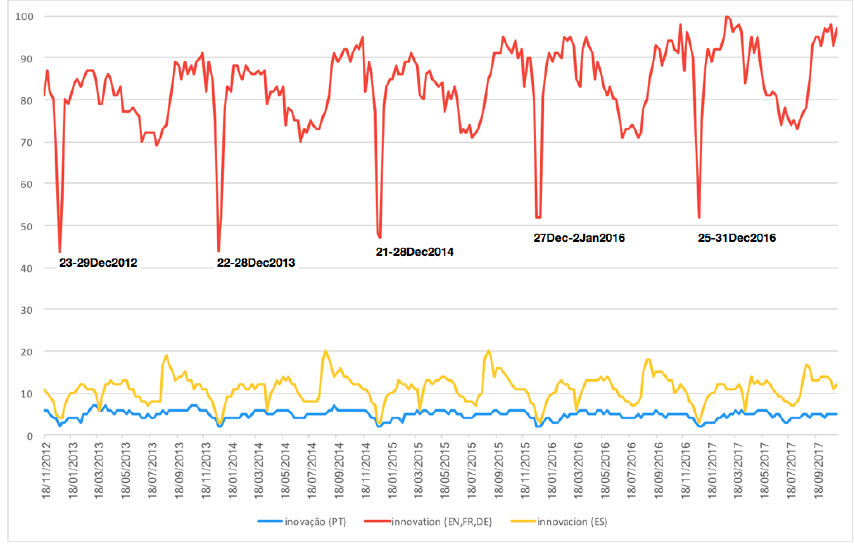
Fig. 1. World interest along the time. Innovation (EN, FR, DE), Innovacion (ES) and Inovação (PT) as a search term in https://trends.google.com for the last five years. 100% translates a peak of popularity 1